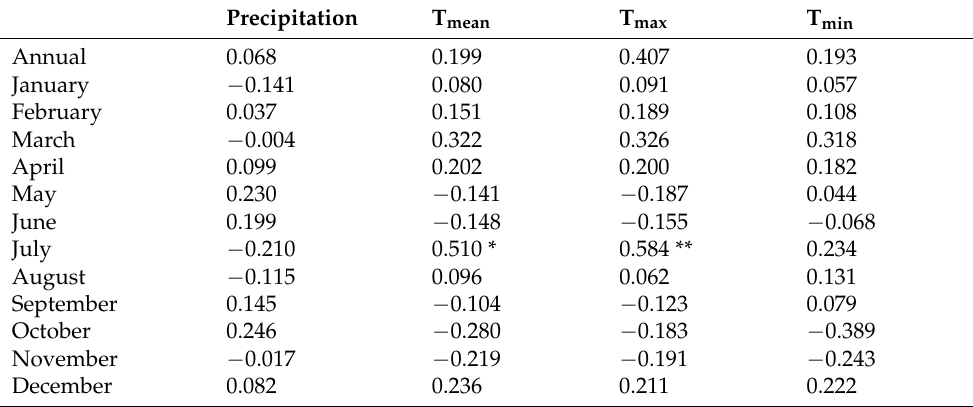
Table 2. Correlation coefficients between growing season NDVI of marsh vegetation and annual and monthly T mean , T min , T max and precipitation in Sanjiang Plain from 2000 to 2020. Precipitation T mean T max T